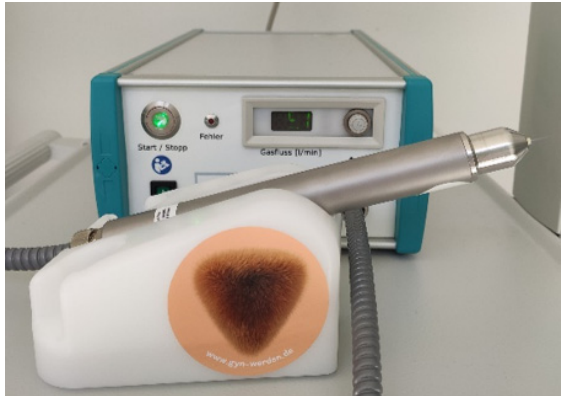
Figure 1. The Kinpen Med medical argon plasma device (Neoplas Tools, Greifswald, Germany) was used to generate non-invasive physical plasma (NIPP).